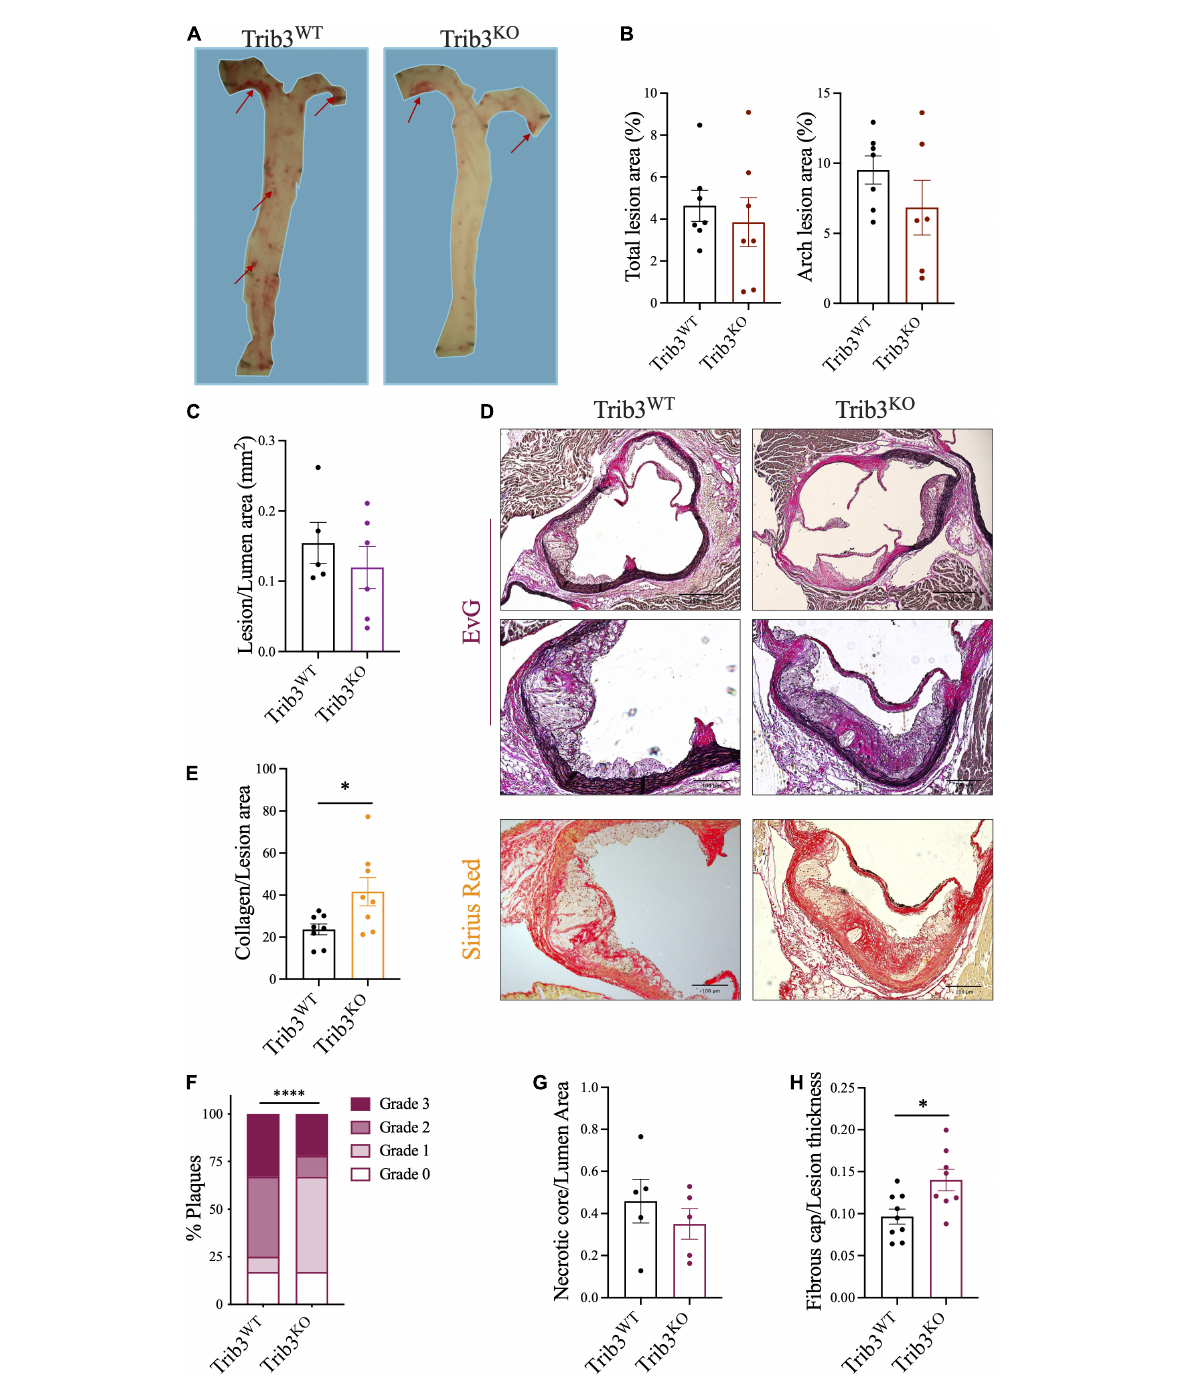
FIGURE3 Atherosclerotic lesion size, disease progression and features in Trib3 KO mice. (A) Representative images and quantification (B) of atherosclerotic lesions stained with ORO in the inner lumen of the aorta and in the aortic arch. (C) Total lesion quantification in the aortic root. Graphs are shown as the mean ± SEM, each data point represents a single mouse, unpaired t -test. (D) Representative images of Elastic van Gieson [elastin, original, and inset (high power image)] and picosirius red (collagen) stained cross-sections of aortic root lesions. (E) Collagen content quantification using picrosirius staining shown as mean ± SEM where each data point represents a single lesion; un-paired t -test ∗ p < 0.05. (F) Double-blind plaque grading, made according to classification in Supplementary Table 2 , presented as percentage of the total number of lesions ( n = 14–17 lesions) using a Chi-square test, ∗∗∗∗ p < 0.0001. The necrotic core relative to lumen area (G) and fibrous cap relative to lumen thickness (H) quantification shown as mean ± SEM where each data point represents a single lesion where more than one lesion was assessed per individual mouse for a N = 6 mice for each group; un-paired t -test ∗ p < 0.05. Scale bars represent 100 µ